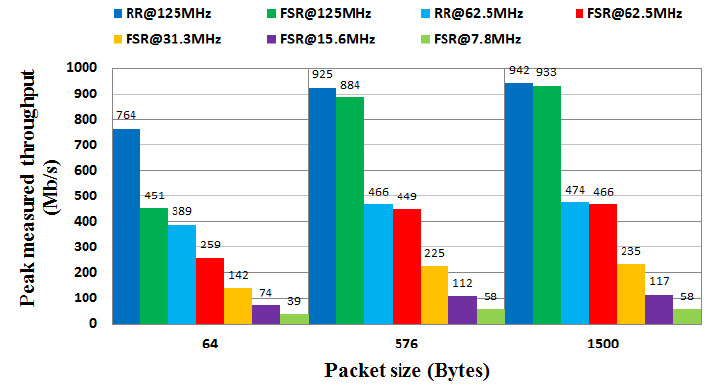
Figure 11. Link capacity of the RR and the FSR under different frequencies and packet